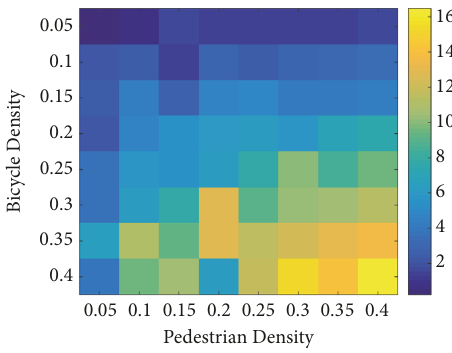
Figure 8: Average conflict numbers per second for path with harbor-shaped bus stop.